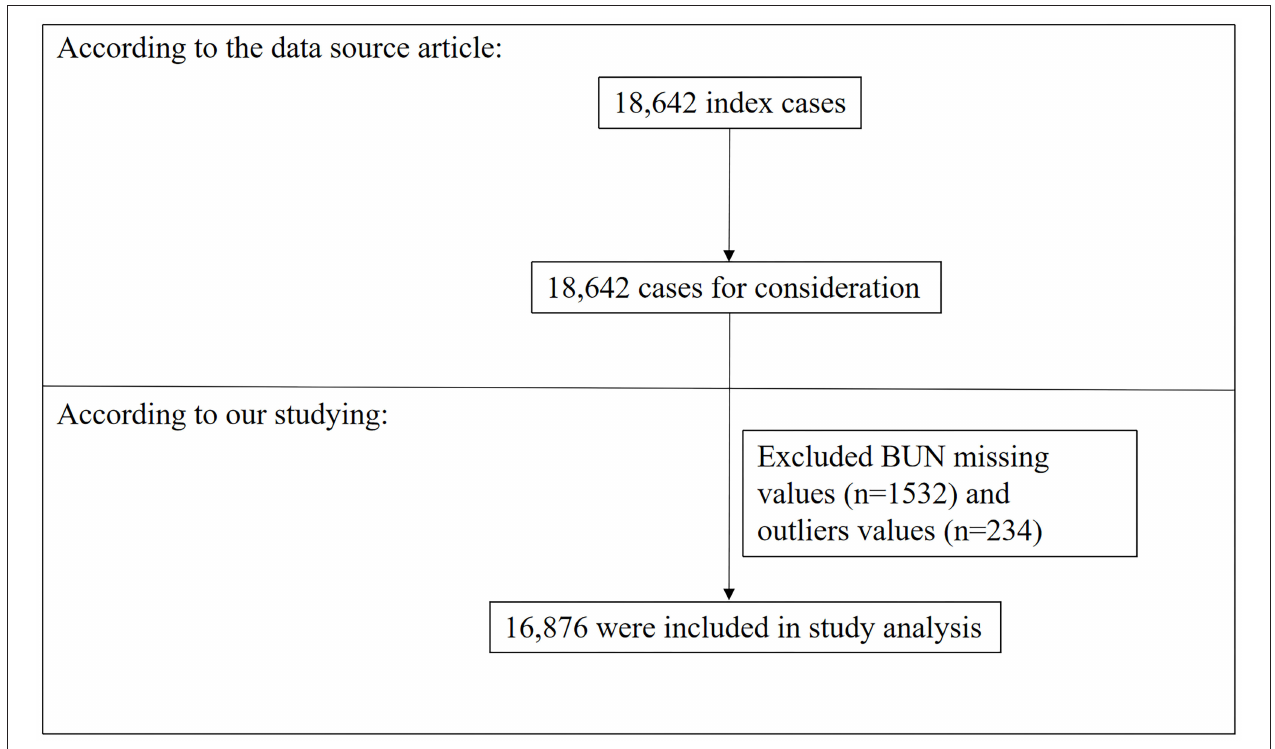
FIGURE 1 | Flowchart of study participant selection.